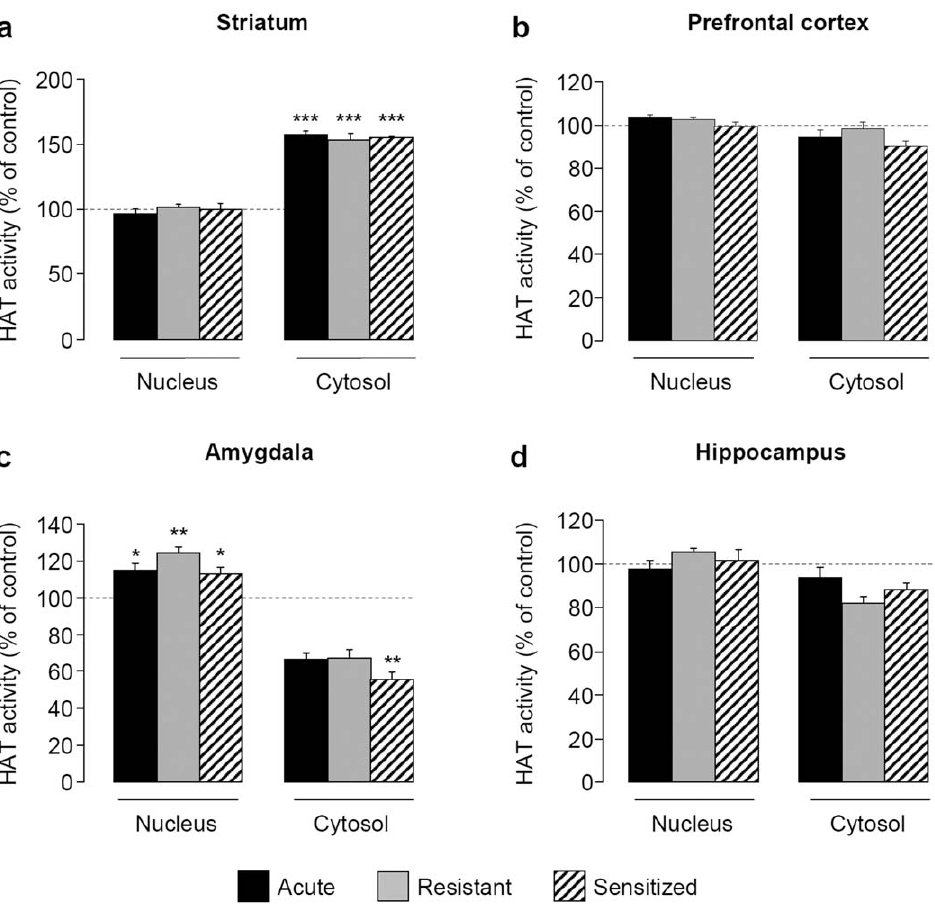
Figure 4. Expression of EIBS is not due to changes in global HAT activity. During 10 days, mice received daily i.p. injections of saline or ethanol (2 g/kg) solution. HAT activity was measured in cytosolic and nuclear fractions of striatum ( a ), prefrontal cortex ( b ), amygdala ( c ) and hippocampus ( d ) 30 min after saline or ethanol challenge (2 g/kg) at day 17 (n=4–5 per group). Means ( 6 SEM) of HDAC activity are expressed as percentages of control * P , 0.05, ** P , 0.01, *** P , 0.001 vs control